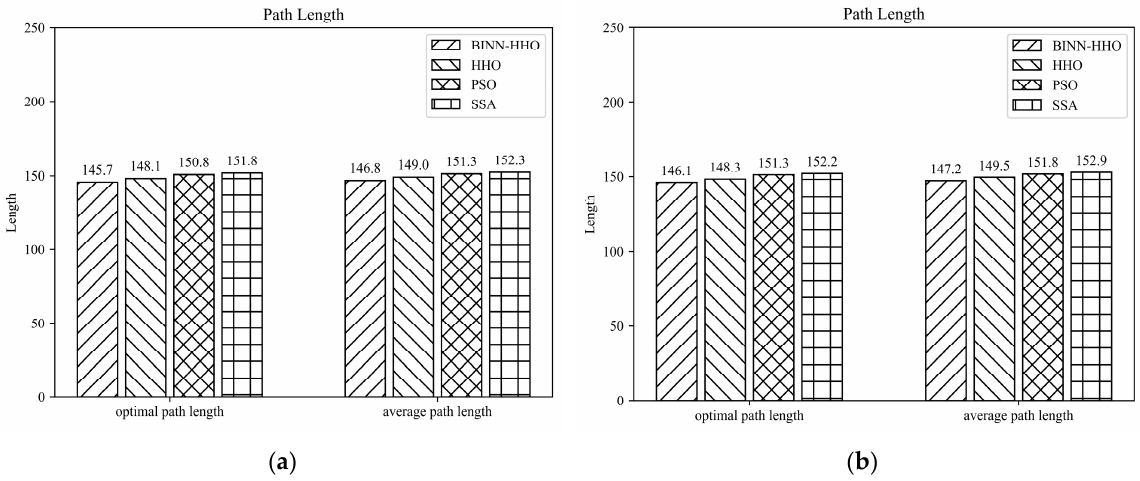
Figure 10. Path planning results of BINN-HHO in a static environment (unit: km). ( a ) Static case I. ( b ) Static case